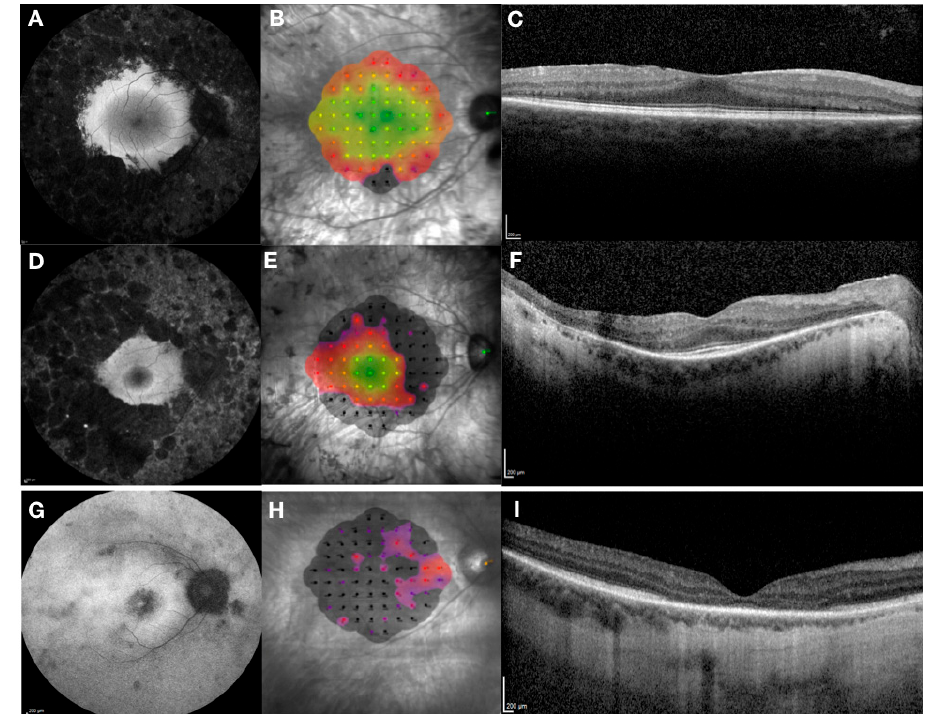
Figure 2. Clinical phenotypes associated with RPGR retinal degeneration—rod-cone phenotype (early stage ( A – C ) and a more advanced stage ( D – F )) and cone-rod phenotype ( G – I ). The phenotypes are captured by Heidelberg fundus autofluorescence, (left column), MAIA microperimetry measuring central retinal sensitivity (central column; sensitivity is represented by a heat map: green/yellow—normal/mildly reduced; red/purple—reduced; black—not measurable) and Heidelberg optical coherence tomography showing retinal structures in cross-section (right column). In rod-cone phenotype there is extensive peripheral retinal atrophy with relative preservation of central retina as seen on autofluorescence associated with para-foveal hyper-autofluorescent ring ( A ). This is confirmed by near normal central retinal sensitivity ( B ) and preservation of ellipsoid zone ( C ). In more advanced stages of the disease there is reduction in size of the para-foveal hyper-autofluorescent ring ( D ) with corresponding reduction in retinal sensitivity ( E ) and length of ellipsoid zone ( F ). In contrast, in cone-rod phenotype there is early loss of para-foveal photoreceptors with associated hypo-fluorescent ring and marked reduction of retinal sensitivity with corresponding loss of the ellipsoid zone.